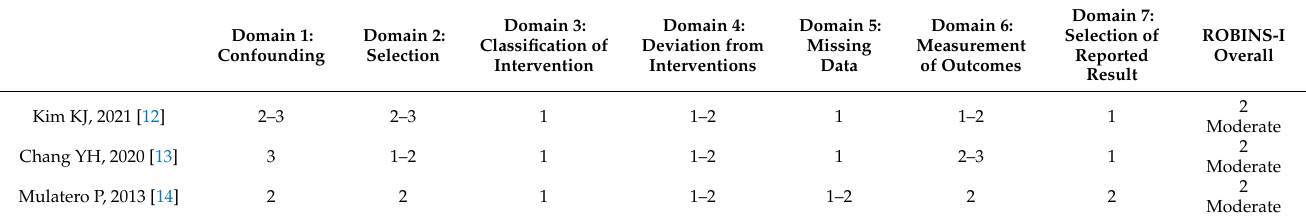
Table 2. Range of overall assessment by study and bias